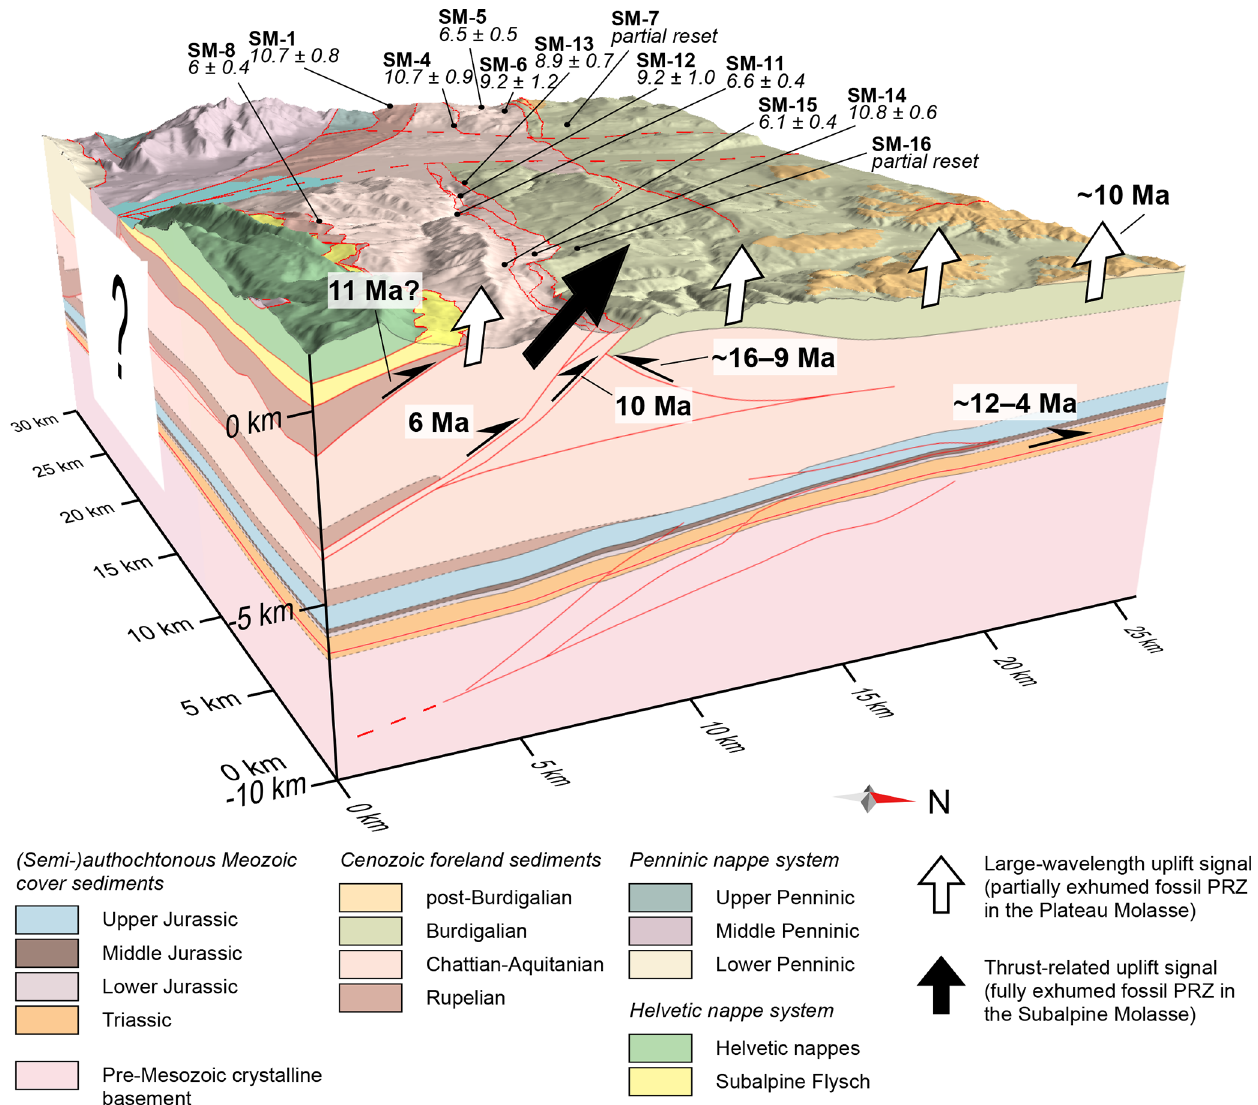
Figure 5. Block model of with sample locations and corresponding average ( U − Th − Sm )/ He ages. The construction of the block model is based on surface (Beck, 1945; Haus, 1937; Jordi, 2012; Rutsch, 1947; Schlunegger et al., 1993, 1997) and subsurface (2D seismic interpre- tation; Mock and Herwegh, 2017) geological information. PRZ, partial retention